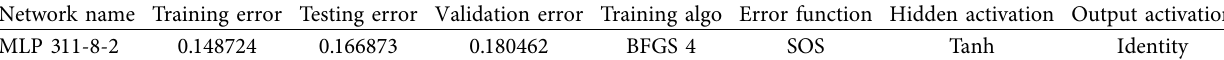
Table 5: Summary of active